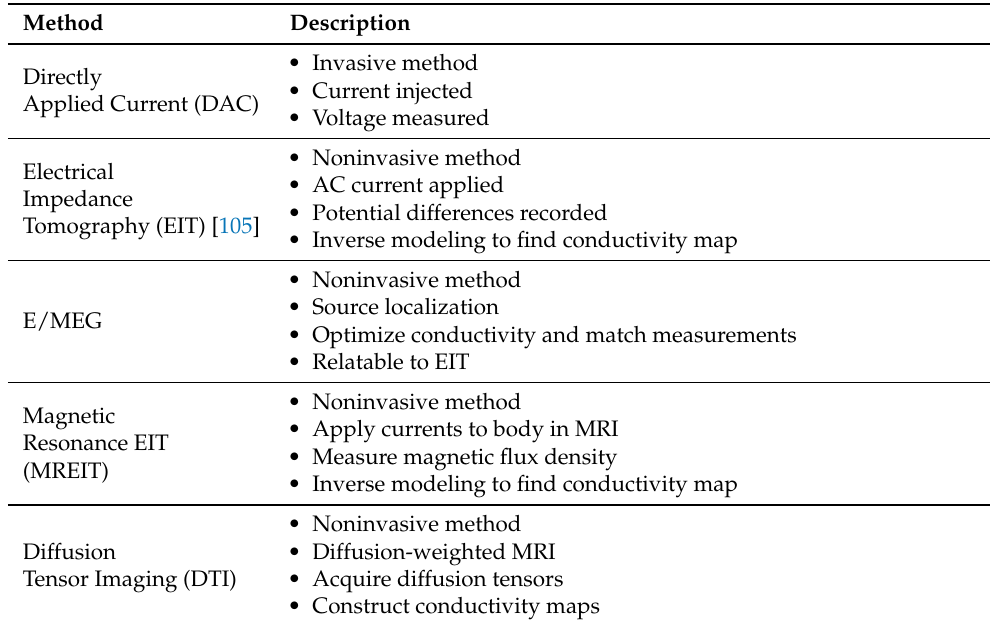
Table 5. Measurement techniques for conductivity